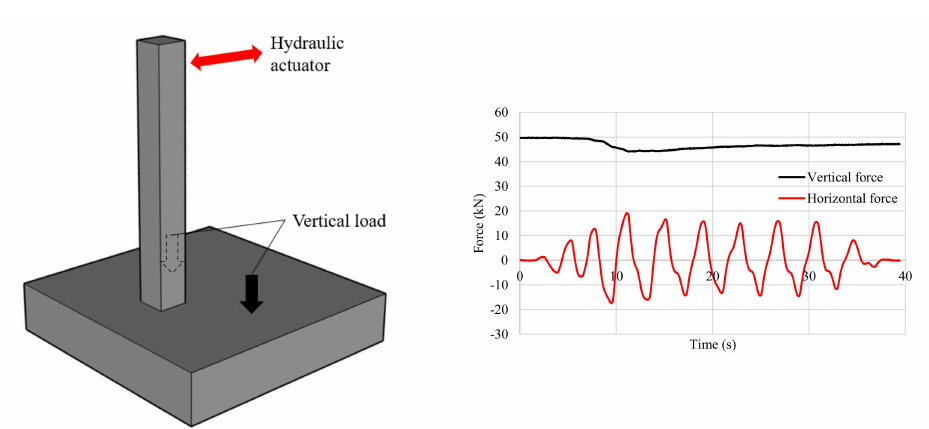
Figure 2. Load application Phase II—low density sand